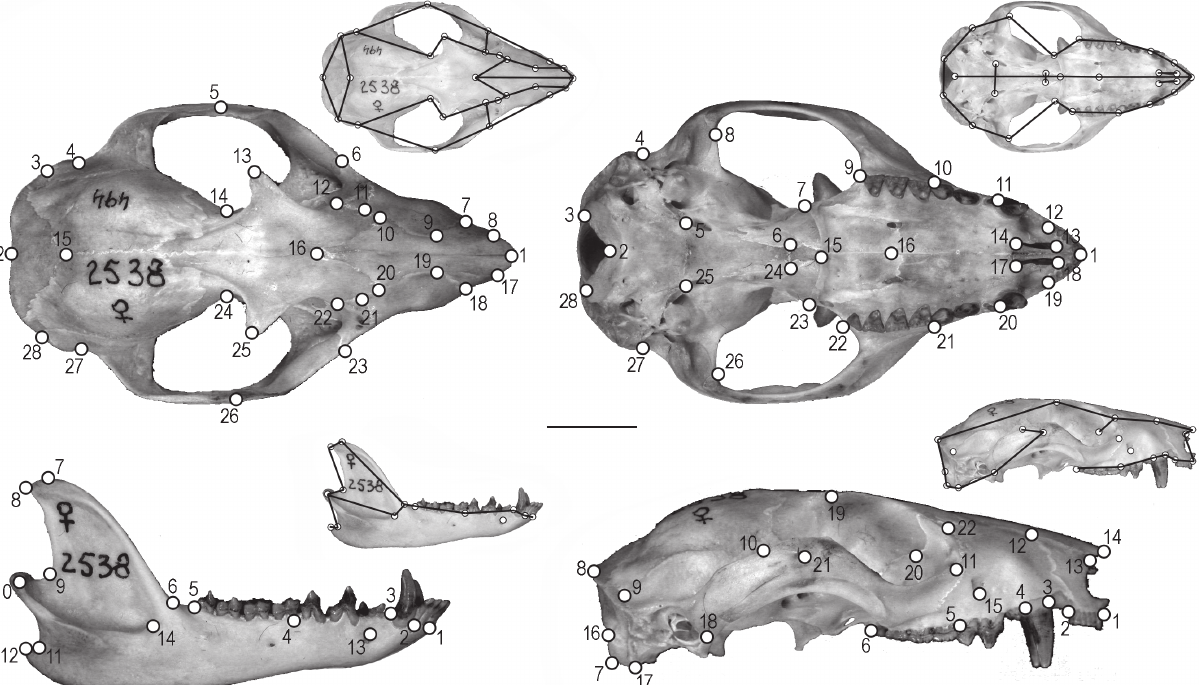
Figure 1. Landmarks used in the cranium and mandible. Smaller versions of each view include landmarks with links, as used deforma- tion grids in subsequent figures. See Appendix 1 for detailed description of landmark locations. Scale bar: 1